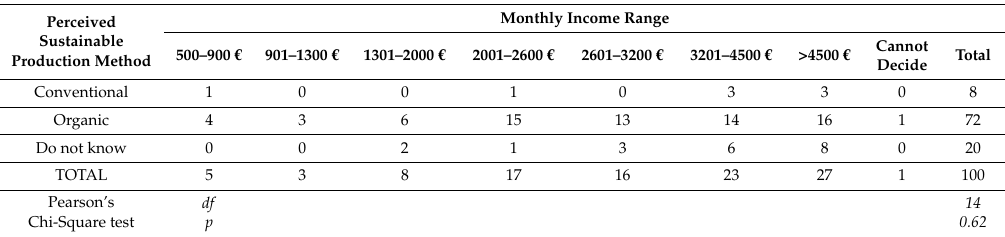
Table 8. Income level and perceived sustainable food production method. The values are in number of participants ( N =